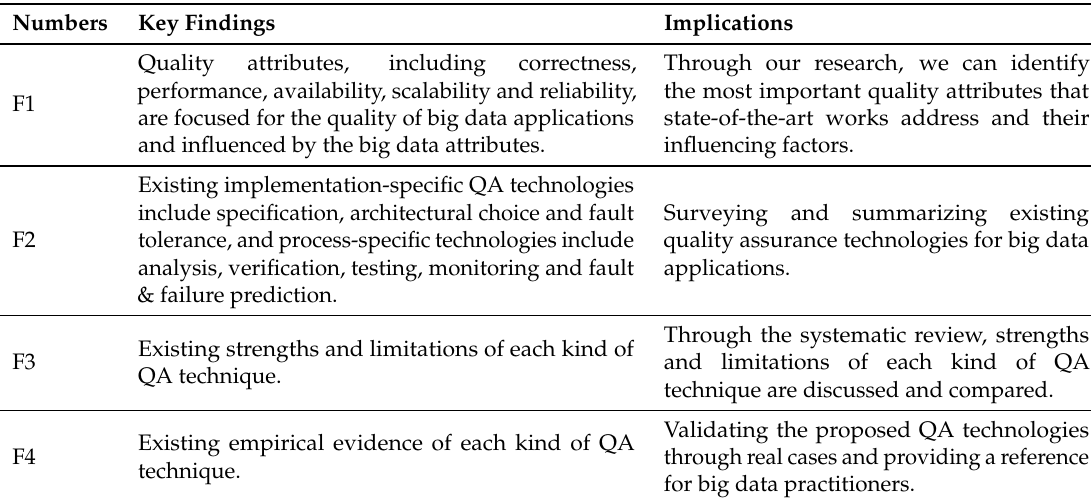
Table 1. Key findings and implications of this